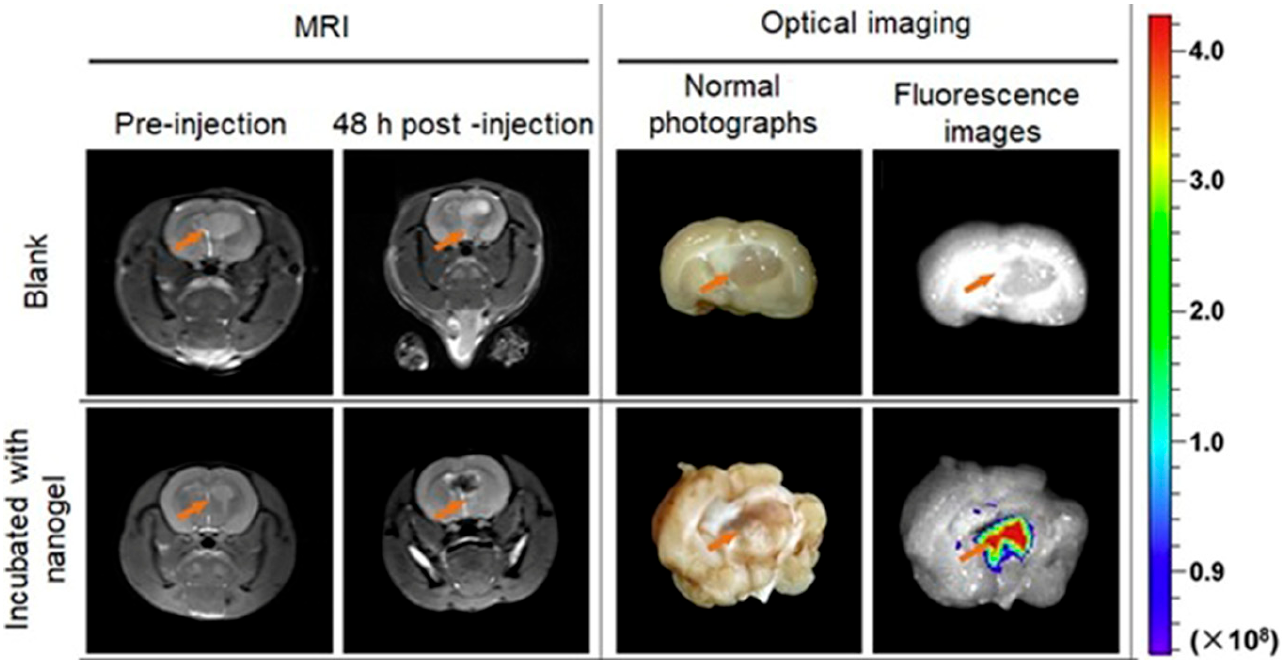
Figure 31. In vivo studies were performed with mice bearing gliomas (n = 9 in a group). Mice treated with saline (blank, upper row ) and nanogel ( bottom row ). Images were acquired before and after tail vein injection (12 mg Fe/kg body weight). (Left) T 2 -weighted MRI images of gliomas before and 48 h post-injection. (Right) Normal photographs and ex vivo fluorescence images of gliomas at 48 h post-injection. T 2 -weighted MRI of brains acquired 6 h post-injection with nanogel exhibited contrast enhancement (darkening) in the tumor area. Consistently, intense fluorescence images were also observed in the brain 6 h post-injection. Adapted from Biomaterials , 34 , Jiang, L.; Zhou, Q.; Mu, K.; Xie, H.; Zhu, Y.; Zhu, W.; Zhao, Y.; Xu, H.; Yang, X. pH/temperature-sensitive magnetic nanogels conjugated with Cy5. 5-labeled lactoferrin for MR and fluorescence imaging of glioma in rats, 7418–7428, Copyright 2013, with permission from Elsevier [311].